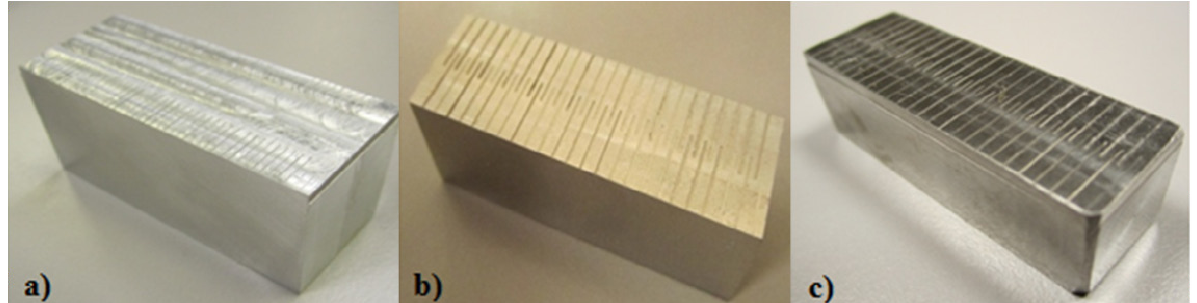
Figure 6. Workpiece probes: ( a ) Al alloy (56 mm × 23 mm); ( b ) AISI 316L (40 mm × 14 mm); Al V (42 mm × 14 ( c ) Ti 6 4